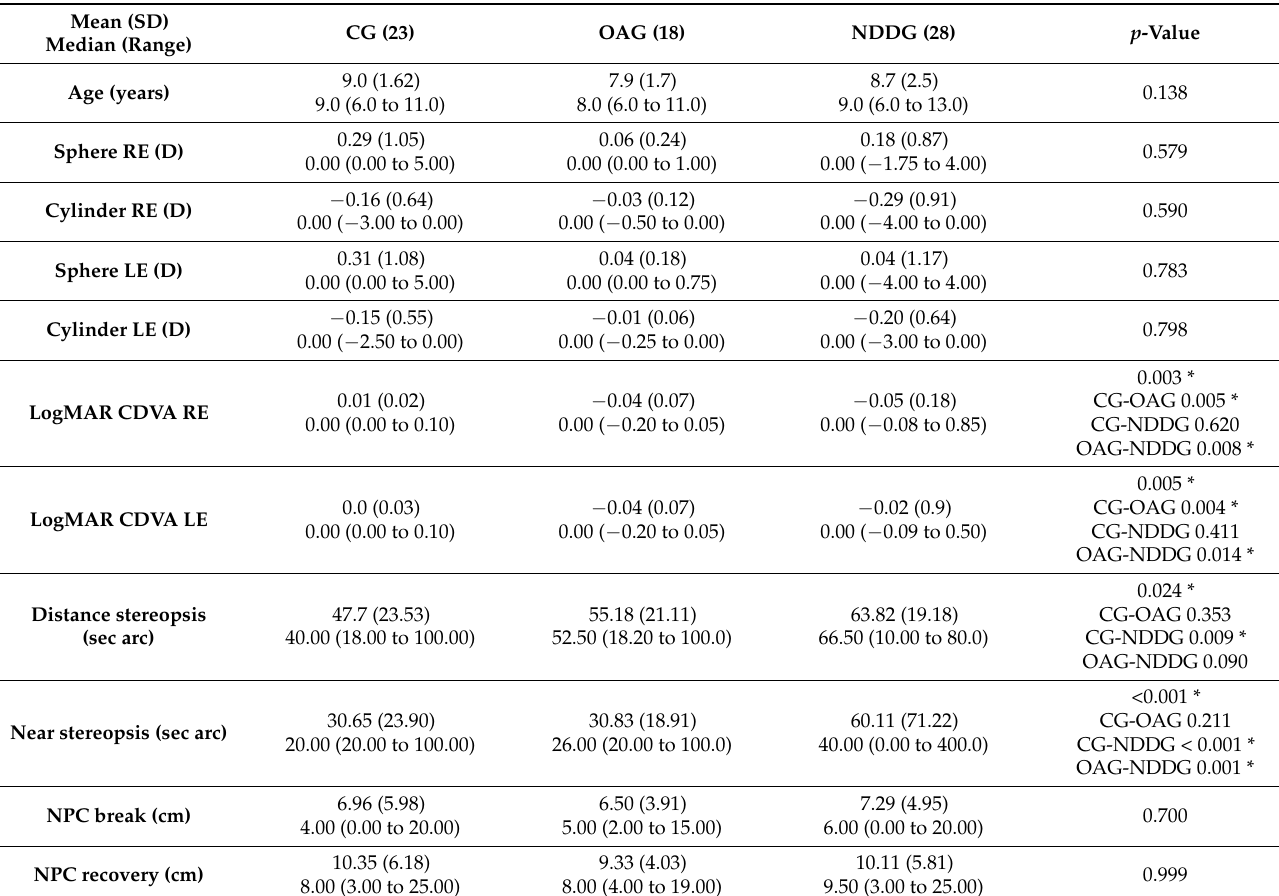
Abbreviations: RE, right eye; LE, left eye; D, diopter; CDVA, corrected distance visual acuity; NPC, near point of convergence. The results of the cover test are expressed as negative in the presence of exophoria and positive in the presence of esophoria. * p -values representing statistically significant differences ( p -value <